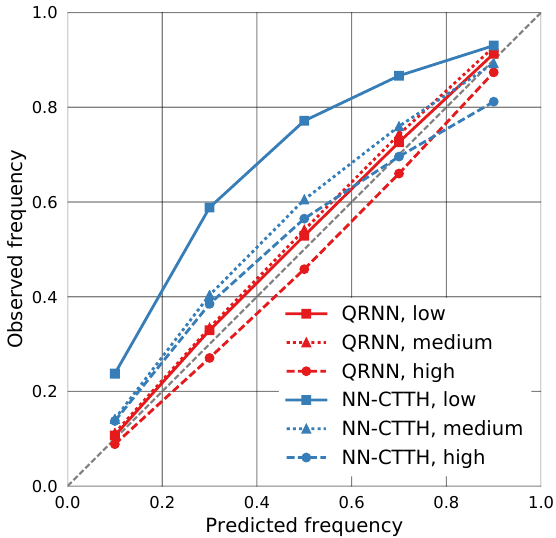
Figure 12. Calibration plot for prediction intervals derived from the Gaussian error model for the NN-CTTH algorithm (blue), the single QRNN (dark gray) and the ensemble of QRNNs (red).